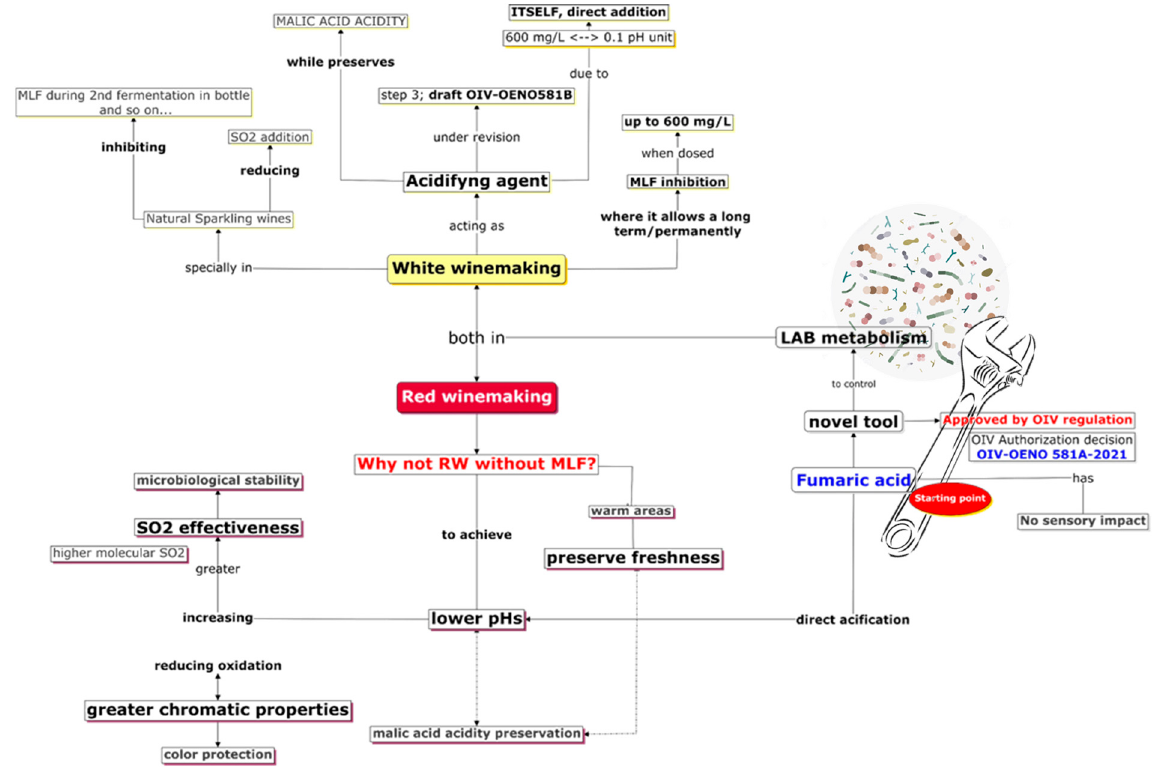
Figure 1. Main impacts in enology of the use of Fumaric acid as inhibitor of malolactic fermenta-